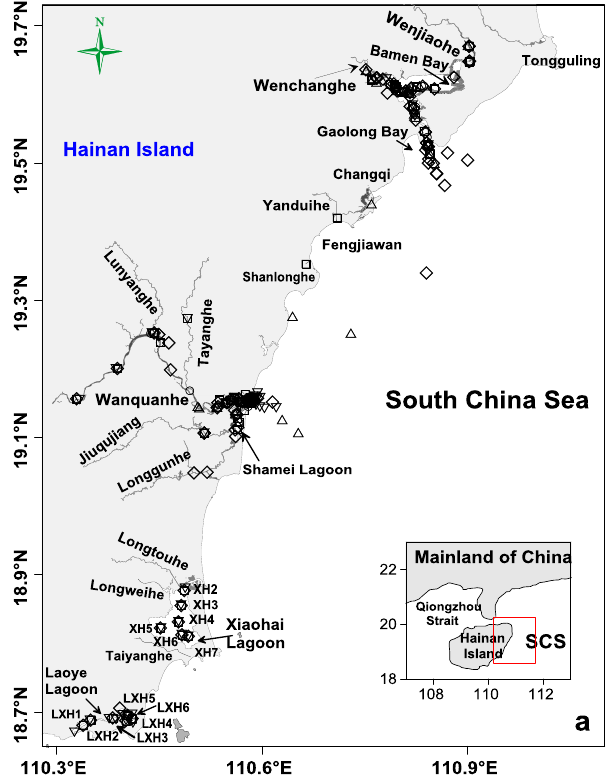
Fig. 1. Location map of the study area and stations for the sampling cruises along the eastern Hainan Island during 2006–2009. (a) : Sampling stations for the cruises in rivers and estuaries, and for shrimp ponds, groundwater and lagoons of the South China Sea in December 2006 (△ ), August 2007 (○ ), June–August 2008 (◇ ), March–April 2009 (□ ), and June–August 2009 (▽ ). Anchor stations sampled in August 2007 (T2-3) and June 2008 (T2-2). The inset at the lower right (a) is the location map. (b) : Sampling stations in coastal waters of the northern South China Sea (SCS) in August 2007 (○ ), June–August 2008 (◇ ), August 2008 (◄), March–April 2009 (□ ) and June–August 2009 (▽ ) (16: anchor station).